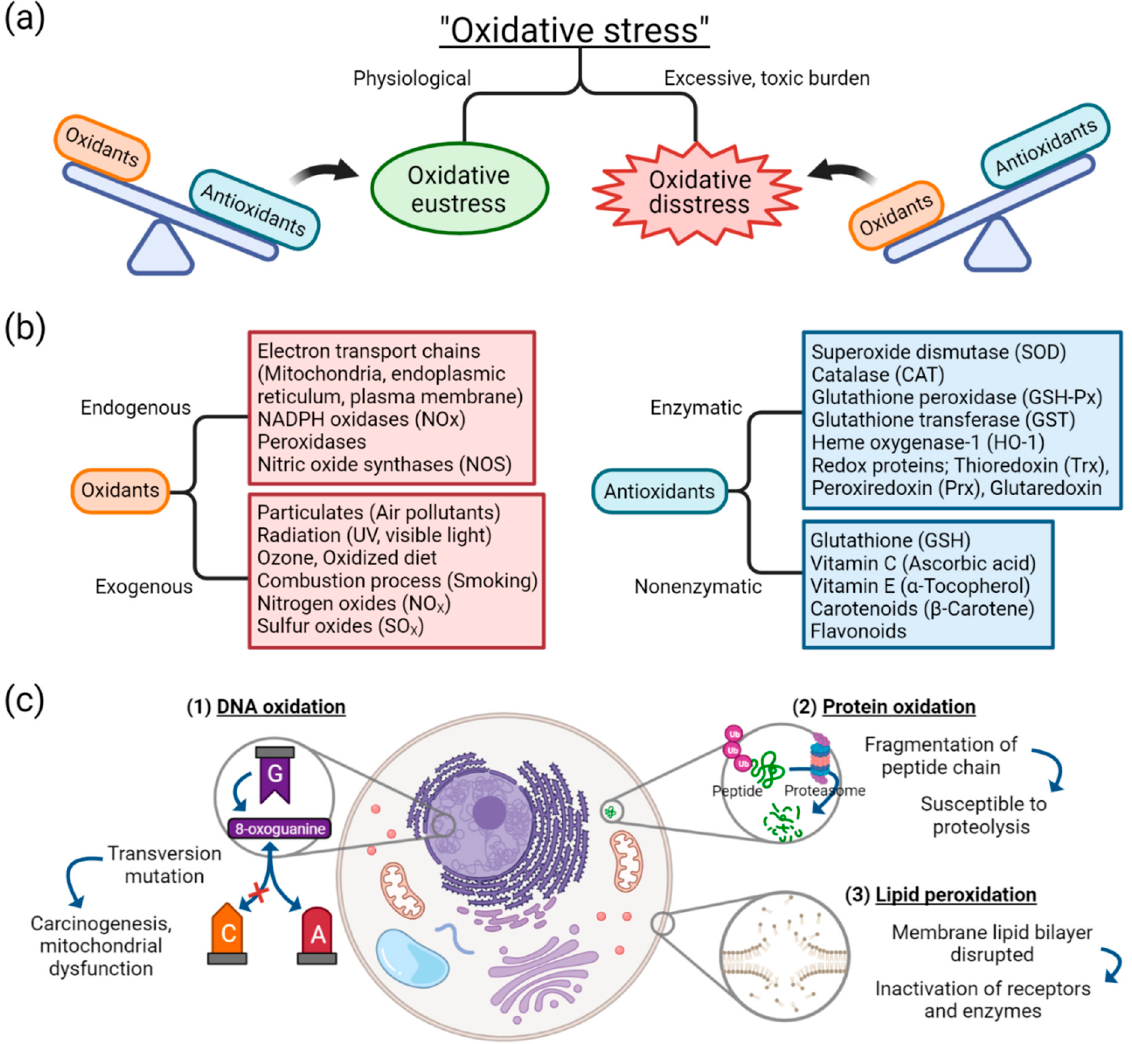
Figure 1. Basic concepts and components of oxidative stress: ( a ) oxidative stress is distinguished as either oxidative eustress or oxidative distress, depending on the balance between oxidants and antioxidants; ( b ) sources of oxidants and antioxidants; ( c ) effect of oxidative damage on biomolecules of DNA, proteins, and lipids. Abbreviation: DNA, deoxyribonucleic acid.